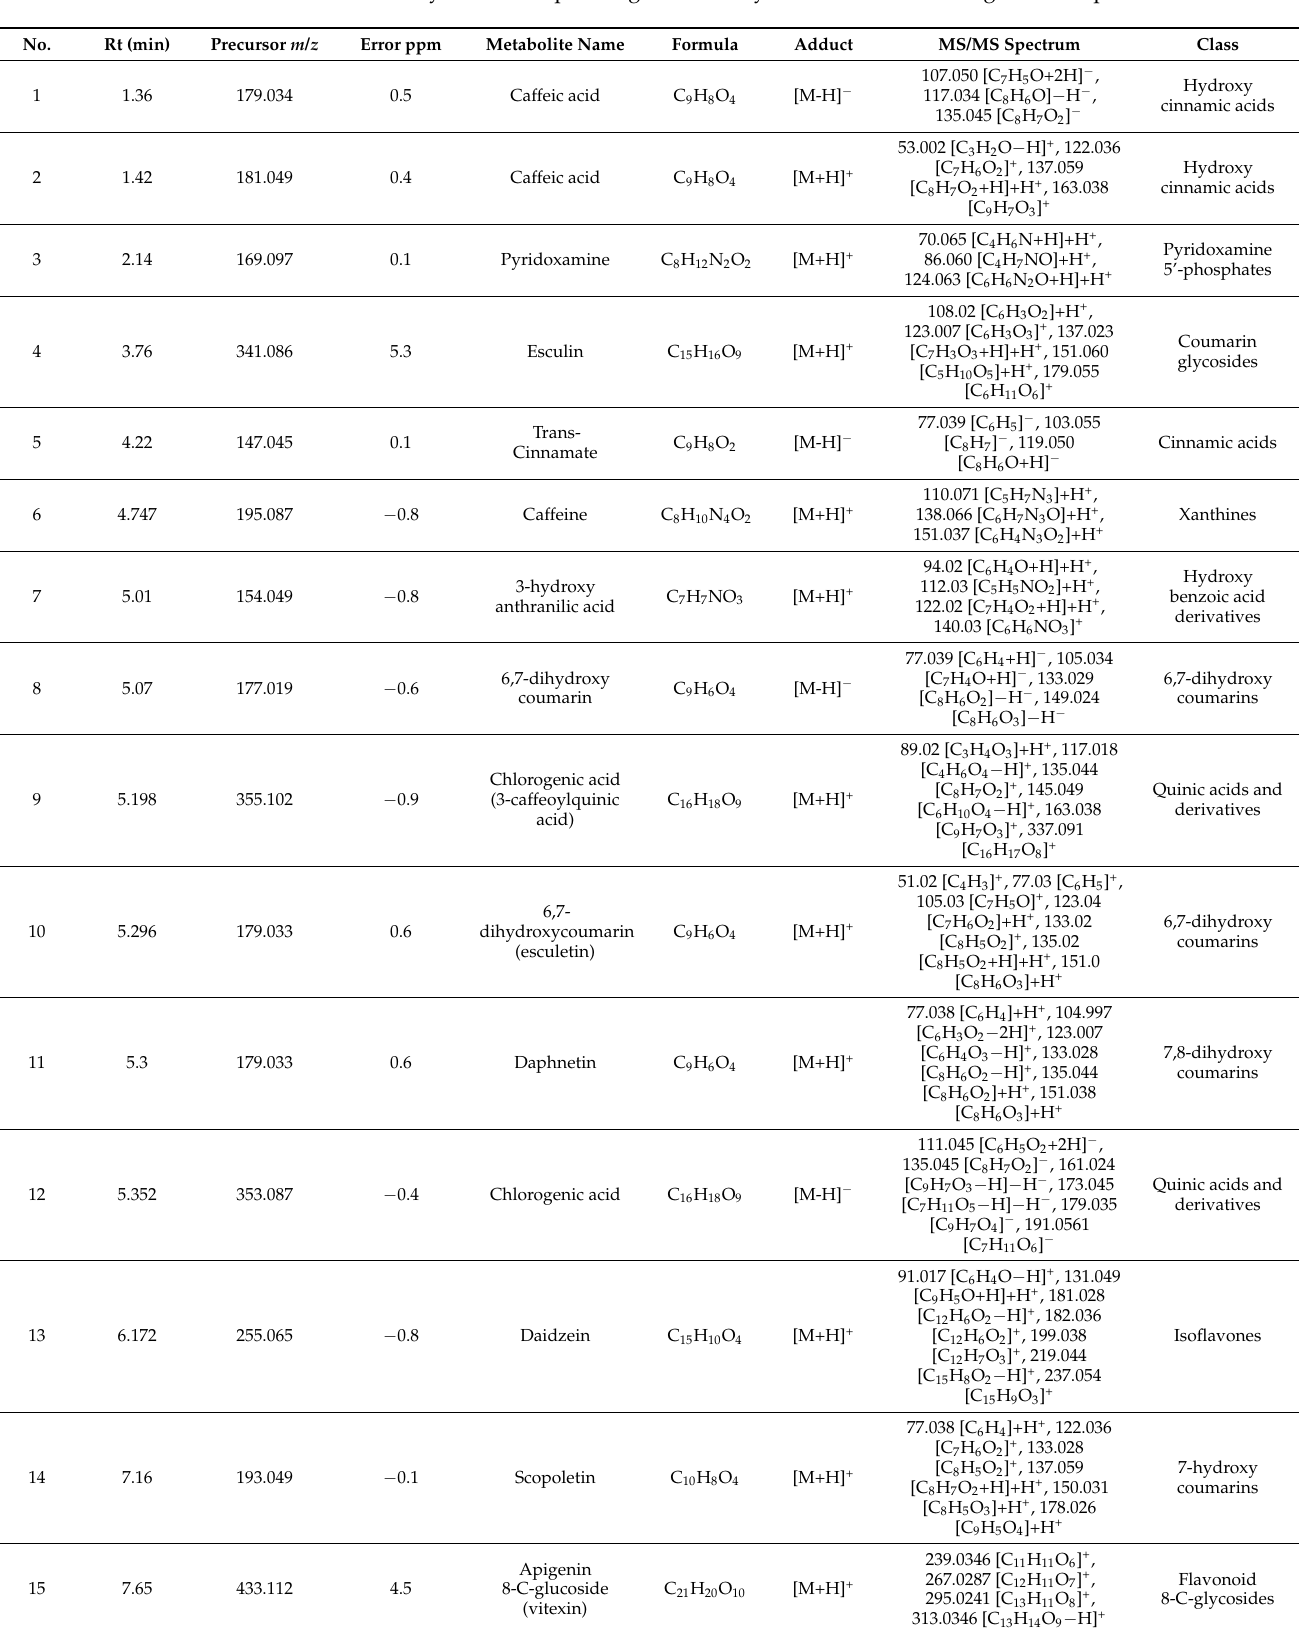
Table 1. Phytochemical profiling of SAME by LC-ESI-MS/MS in negative and positive